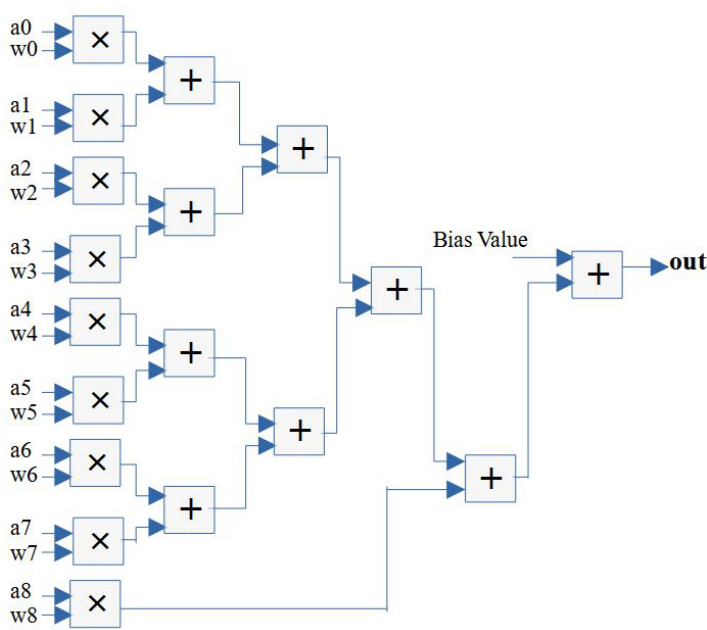
Figure 6. Streaming design structure of a convolutional layer